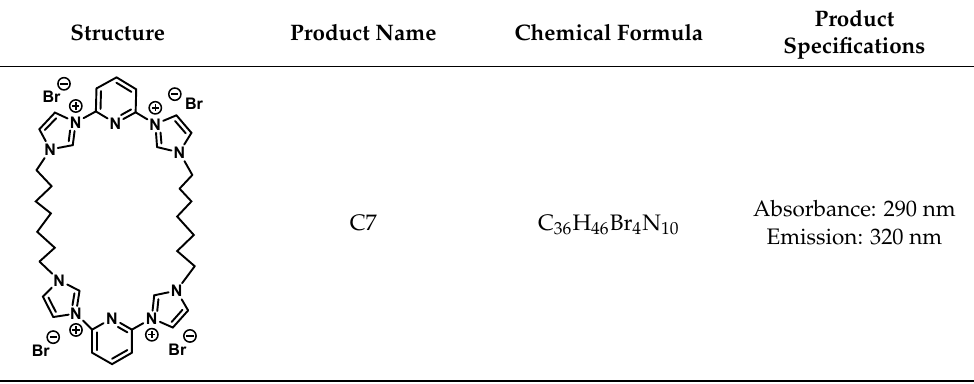
Table 1. Synthesized heterocyclic carbene ligand structure, absorbance data.